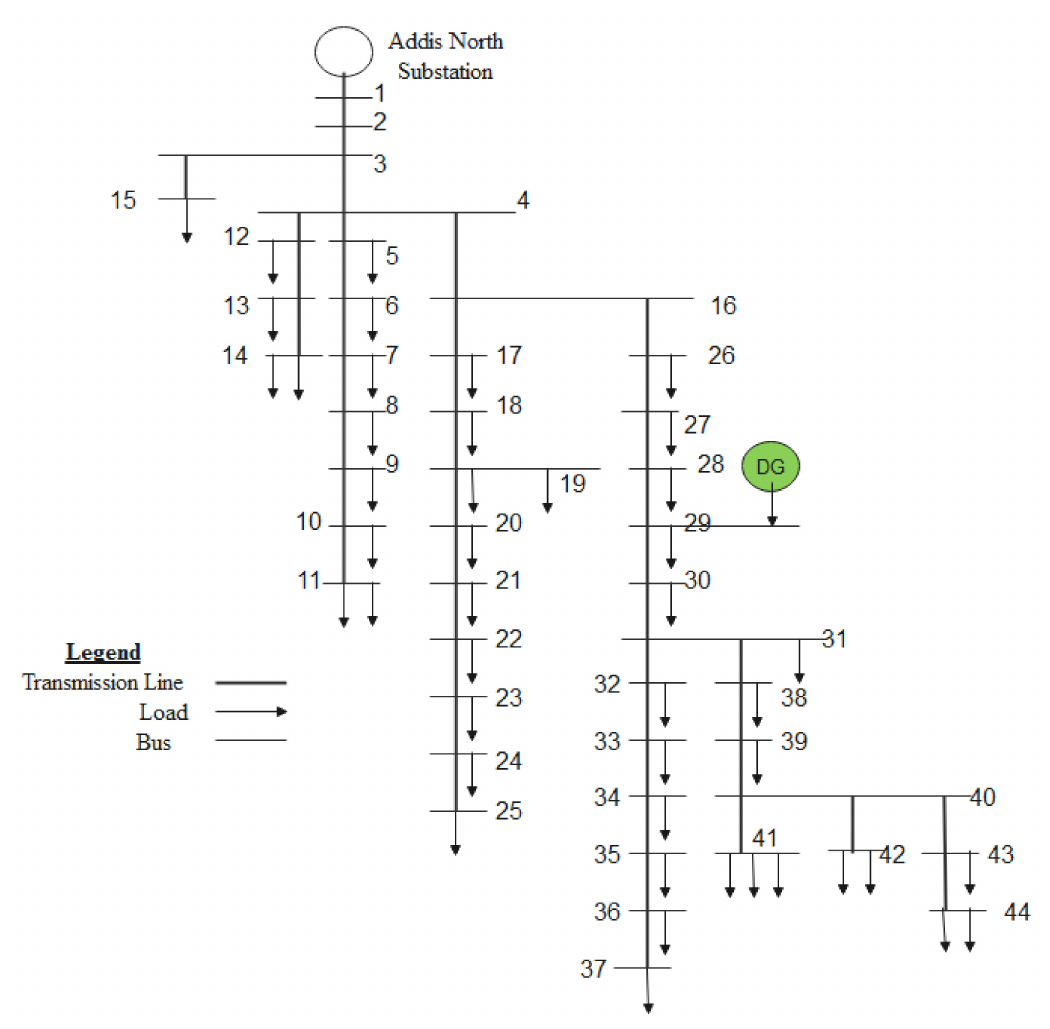
Figure 9. Single Line Diagram for Addis North-1with